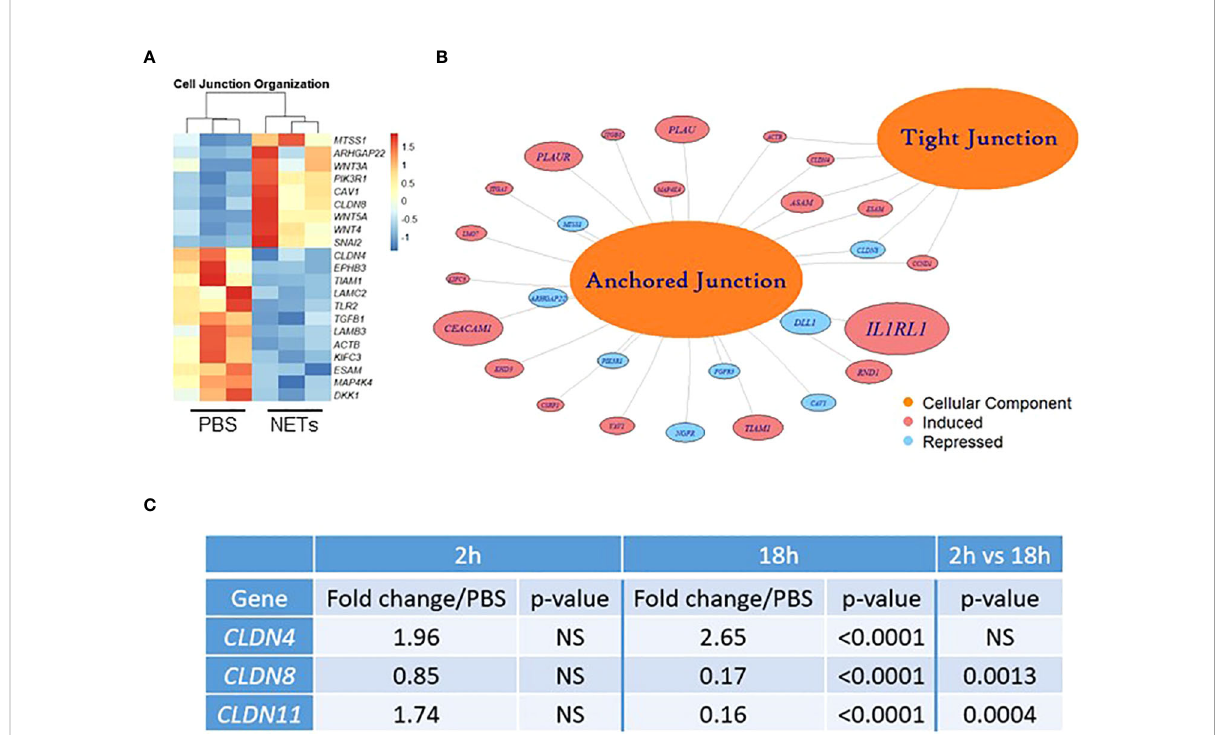
FIGURE 3 NETs alter bronchial epithelial cell junction genes. HBE grown at ALI exposed to PBS control or 5µg/ml NETs in the apical compartment in triplicate wells. (A) Differentially expressed genes involved in cell junction organization visualized in a z-scored normalized heat map offragments per kilobase of transcript per million mapped reads ( FPKM) demonstrate signi fi cant changes in HBE exposed to NETs for 18h. (B) Functionally enriched RNAs for cellular components of anchored junctions and tight junctions in HBE impacted by NET exposure for 18h, analyzed using ToppGene (experiments=3, HBE donors=3, NET donors=3). (C) Changes in junctional RNAs after 2 or 18h exposure to NETs were con fi rmed by RT-qPCR and normalized to 18S. Data analyzed by unpaired t-test (NS, not signi fi cant; experiments=3, HBE donors=4, NET